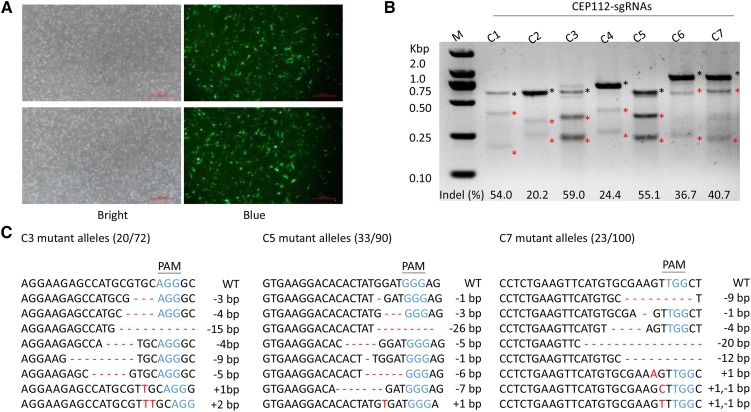
Screening of sgRNA with high cleavage efficiency in CEP112 locus. (a) Fluorescence expression in PFFs co-transfected with sgRNAs and pBb-ubc-eGFP. (b) Determination of the cleavage efficiency by T7E1 assay. The red and black asterisks indicate cut and uncut bands, respectively. (c) Sanger sequencing further confirmed the cleavage rates of sgRNAs C3, C5, and C7 in the CEP112 locus. Eight mutant alleles are used as representatives. Indels are shown in red letters and dashes. Protospacer adjacent motif (PAM) sequences are presented in blue.